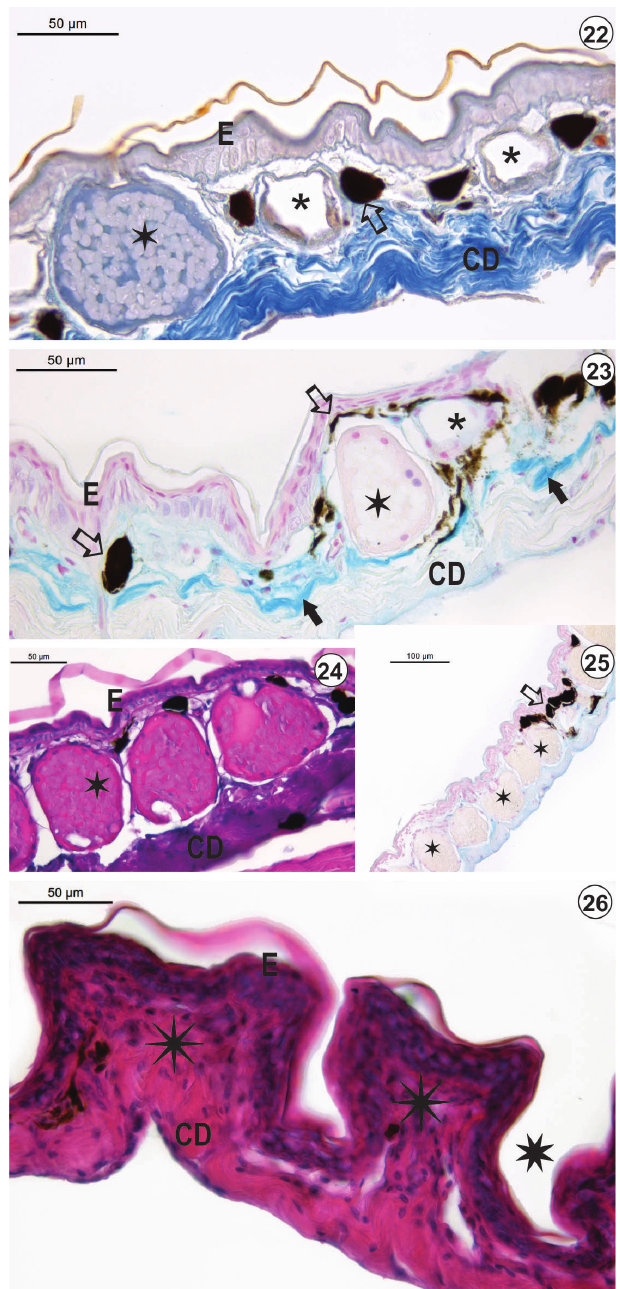
Figures 22–26. Light micrograph of the integument of S. hayii : (22) Dorsal region (Mallory´s trichrome staining); (23) Dorsal region (AB-method); (24) Ventrolateral region (HE-staining) (25) Ventral region (AB-method); (26) Ventral region (HE-staining). In the dorsal integument, exocrine glands are more frequent, mainly the serous glands ( Ø ). Melanophores ( _ ) occur in the spongious dermis, even around the secretory portion of glands. Note clusters of apocrine glands with heterogeneous content ( ¬ )in the spongious dermis of the ventrolateral integument. The EK-layer ( Æ ) is continuous in the dorsal integument, but absent in the ventral region. Slight cutaneous elevations ( á ) in the ventral integument are formed by the epidermis and the dermis, mainly the spongious dermis. They are separated by groves (  ). CD = compact dermis. ZOOLOGIA 34: e20176 | DOI: 10.3897/zoologia.34.e20176 | September 18,